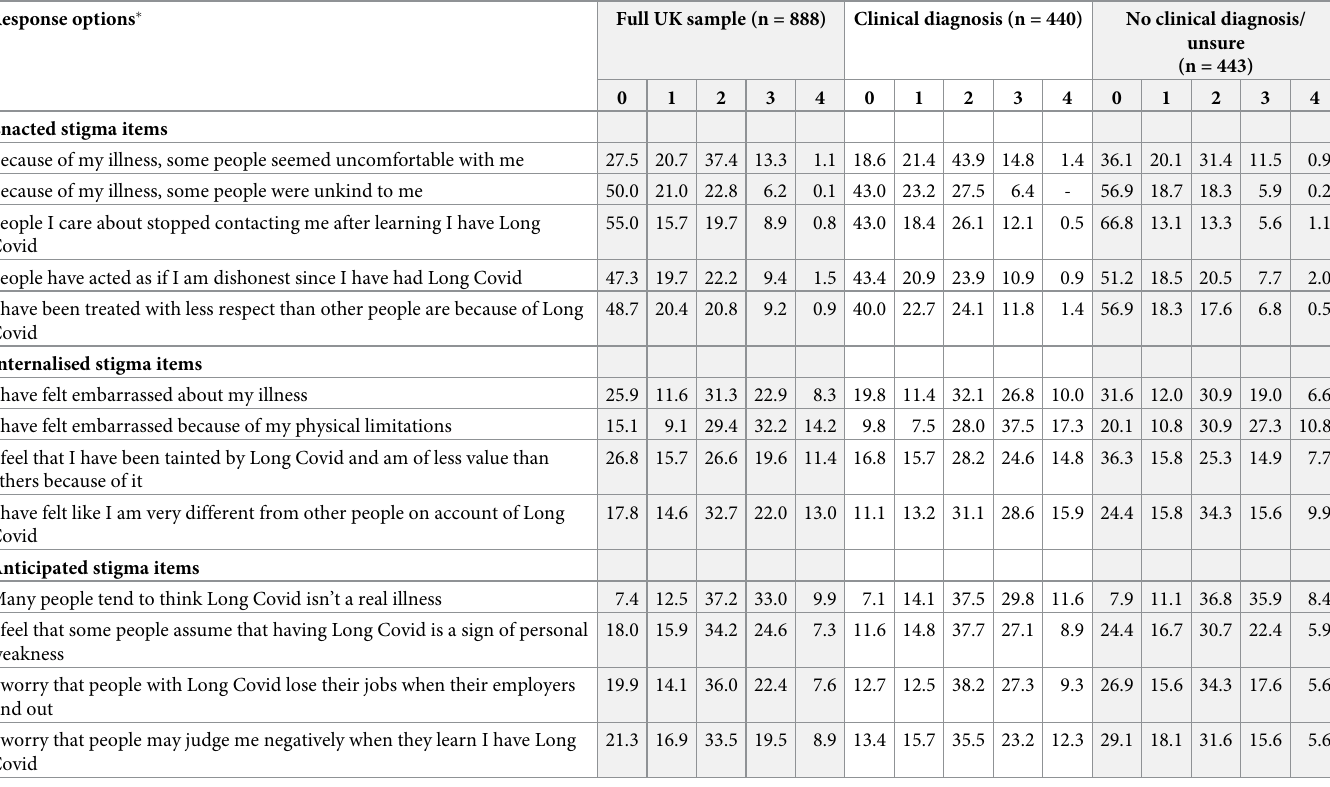
anticipated stigma items were constrained to load onto the anticipated stigma factor; and internalised stigma items were constrained to load onto the internalised stigma factor. Error terms were only allowed to be correlated between items on the same subscales. Results of the CFA are presented in Table 3. Fit indices indicated that the model fitted the data well for the full UK sample, as well as both subsamples. Standardised factor loadings of Table 2. Response option frequencies for each stigma